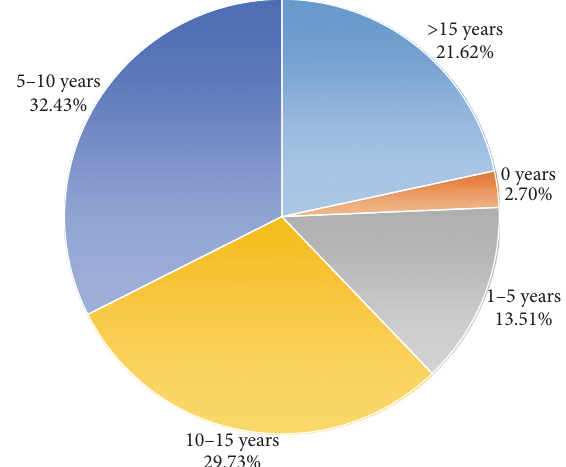
Figure 2: Profile of the respondents. Years of experience